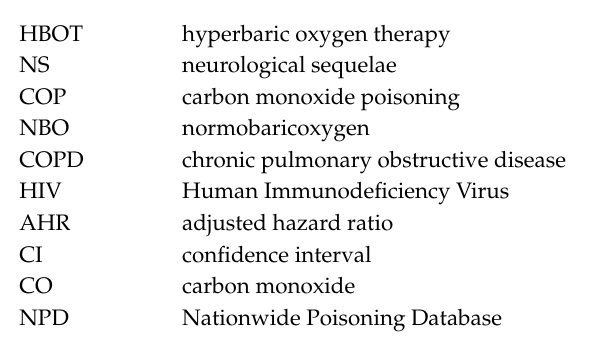
Table S1: Demographic characteristics, underlying comorbidities, monthly income, and concomitant conditions in the patients with COP between 1999 and 2012, Table S2: Comparison of the risk for NS between patients with COP who received HBOT and who did not by Cox proportional hazard regression